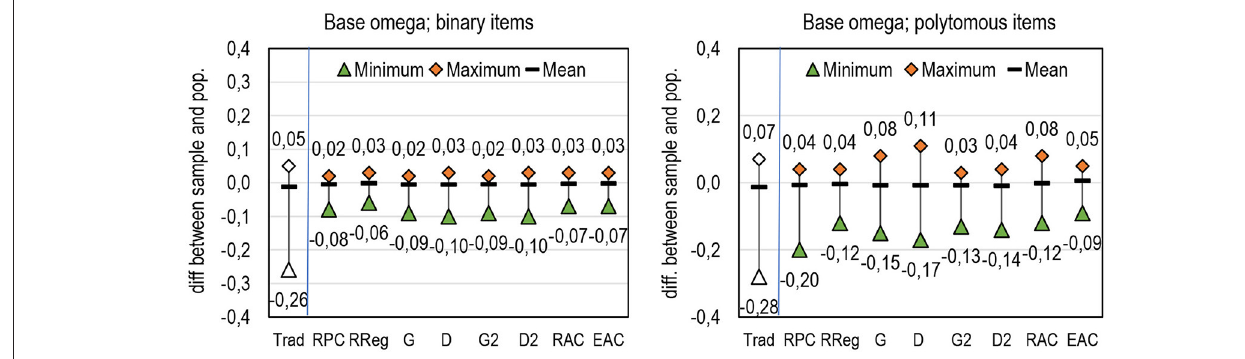
FIGURE 7 | Deviance between sample and population estimates in DCERs based on omega.